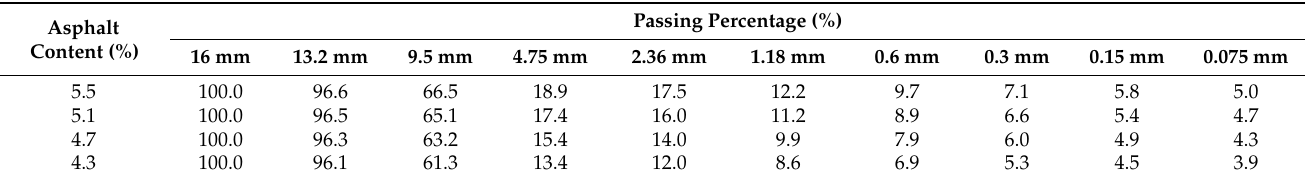
Table 1. EPA-13 mineral aggregate